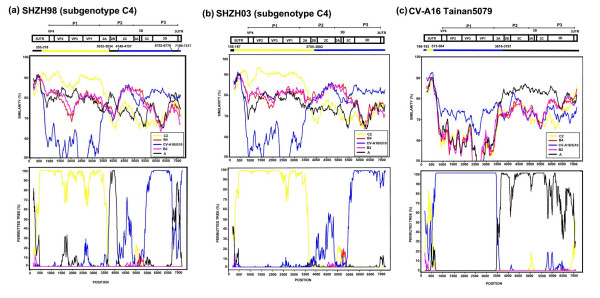
Identification of recombinant sequences in the genome of EV-71 subgenotype C4 and CV-A16 Tainan 5079. The organization of the EV-71 genome, the respective crossover breakpoints and potential parental sequences are shown. The upper panel shows results of a pairwise comparison between SHZH98 (a), SHZH03 (b) and CV-A16 Tainan 5079 (c) genome sequences against the consensus sequences of EV-71 genotypes A, B2, B4, C2, and CV-A16/G10. The lower panel shows results from the bootscan analysis which illustrates the likelihood of clustering of the putative recombinants with respect to the parental virus. A window size of 400 nucleotides in increments of 20 nucleotides at a time was used. Positions containing gaps were excluded from the comparison.